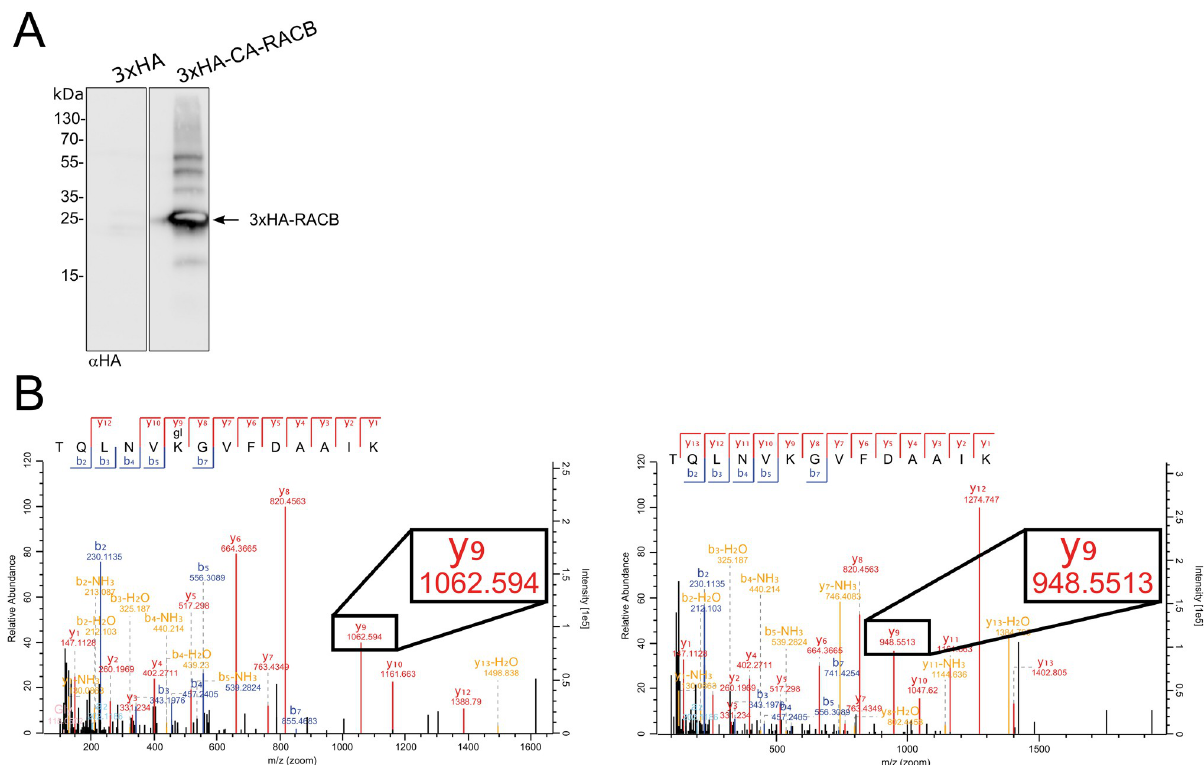
Fig 4. Constitutively activated RACB is ubiquitinated in vivo . (A) HA-tagged CA-RACB and higher molecular weight bands were detected in an α HA-Western blot after MG132 treatment and α HA-immunoprecipitation from whole barley leaves stably expressing 3xHA or 3xHA-CA-RACB (S2B Fig). Plant material was pooled from transgenic lines BG657 E3 and E4 for 3xHA-CA-RACB and BG659 E2 and E3 for 3xHA. (B) Ubiquitination of CA-RACB at K167 was identified by mass spectrometry in a workflow described in S2B Fig. The left graph shows spectra of the recovered ubiquitinated peptide, while the right graph shows the corresponding unmodified peptide. The black box illustrates one example of such a size difference: fragment “y9” was recovered with two different masses. The difference corresponds to that of 2 glycines, which is typical after a tryptic digest of ubiquitinated proteins [44]. Example: y9 modified (1062.59 m/z)–y9 unmodified (948.55 m/z) = 114.04 m/z = 2 � glycine (57.02 m/z).